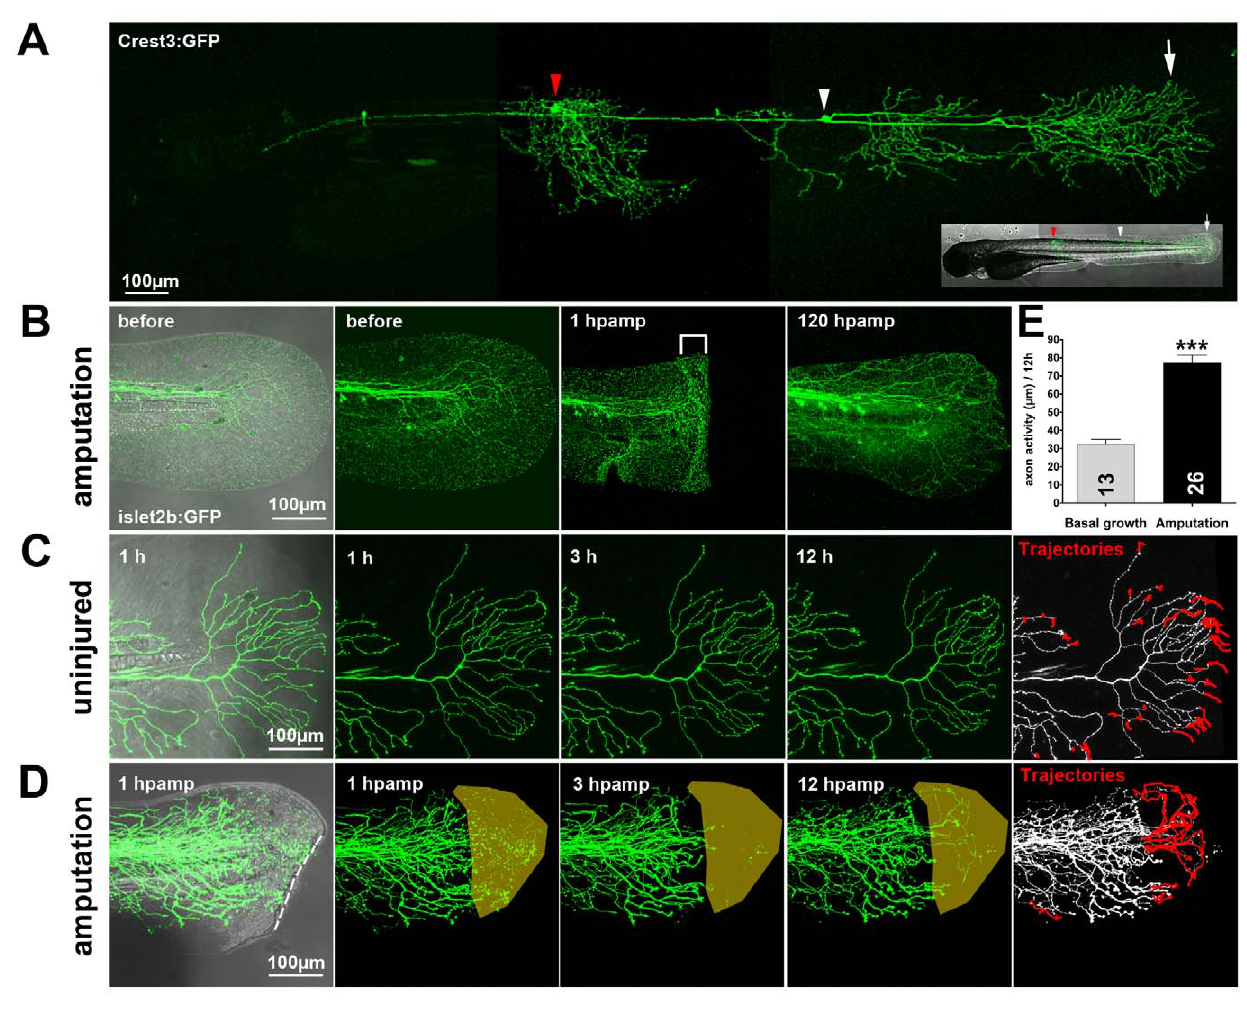
Figure 1. Amputation promotes peripheral sensory axon regeneration in the fin epidermis of 78 hpf zebrafish larvae. (A) A transient transgenic larva expressing GFP in two RB neurons: one innervating the trunk (red arrowhead) and one innervating the tail fin (white arrowhead). Arrow indicates the RB peripheral arbor in the tail fin. (B) Fin amputation in a 78 hpf islet2b:GFP transgenic larva caused severed axon branches to degenerate at the wound margin (brackets, 1 h post-amputation [hpamp]). RB axon arbors completely reinnervated the regenerated fin by 120 hpamp. (C, D) Time-lapse sequences from 78–90 hpf. The rightmost panel shows axon tip trajectories (red) over the course of the time-lapse (see also Video S1 for a tracing example). (C) The branches of a single GFP-labeled peripheral axon in an uninjured fin underwent minimal growth and retraction. Some of this apparent activity was due to movement of the tissue during time-lapse (see Video S1). (D) Fin amputation (dotted line) increased the growth of the severed arbor (see also Figure 3D, E) and promoted reinnervation of denervated territory (shaded area) (Video S3). (E) Quantification of axon activity in uninjured fins ( n =13) and after fin amputation ( n =26) (two-tailed, unpaired Student’s t -test, *** p , 0.001). Error bars represent the standard error of the mean. hpamp, hours post